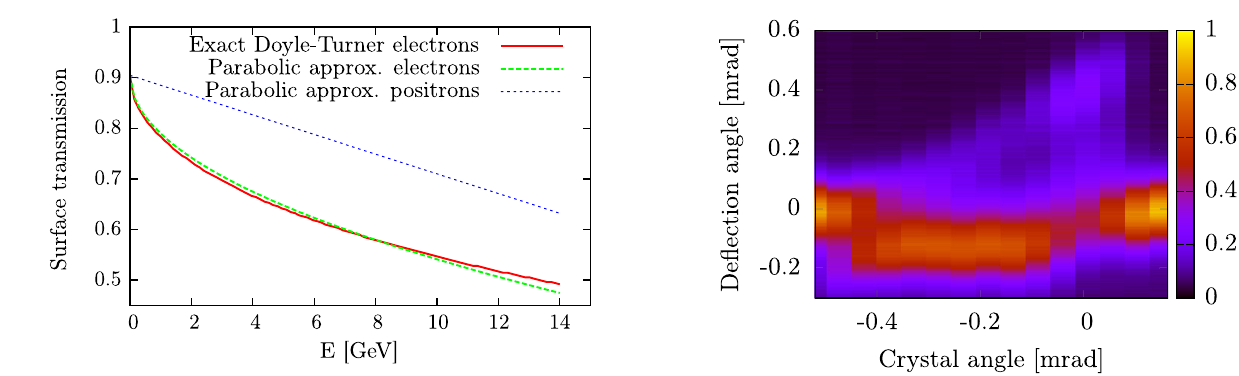
FIG. 2. A figure comparing the surface transmission for electrons using the exact Doyle-Turner potential and the para- bolic approximation. We have also plotted the parabolic approxi- mation for positrons to show the difference between positive and negative particles.